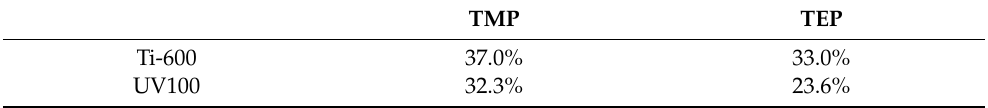
Figure 9. Integrated absorbance (black squares) for the build-up of chelating carboxylates/(bi)carbonates during UV illumination for ( a ) UV100_TMP (1520 cm −1 – 1475 cm −1 ), ( b ) UV100_TEP (1515 cm −1 – 1450 cm −1 ), and ( c ) Ti-600_TMP (1505 cm −1 – 1485 cm −1 ). Data points were taken every 80 s for a total of 8 min for Ti-600 and ~11 min for UV100. The red lines are first-order fittings for y = a(1 − e (−bx) ), where b is the rate constant. Table 2. Rate constants (in units of min −1 cm −2 g) for aldehyde build-up (~1720/1740 cm −1 ), OP de- ylate decomposition (~1530 cm −1 band) for UV100 and Ti-600 during UV illumination, normalized by the specific surface area for each sample. Table 3. Degradation of OPs after 9 min of UV